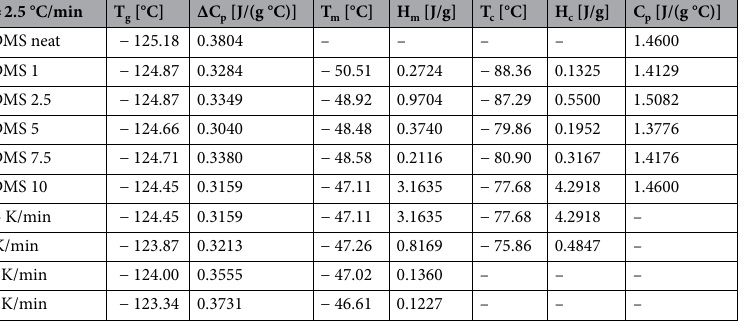
Table 3. Summary of typical values coming from DSC measurement of graphene/PDMS nanocomposites of 1–10 wt% graphene concentration. The heating rate remained constant: 2.5 °C/min. C p was measured in quasi-isothermal mode. The second part of the table shows a summary of typical values coming from DSC measurement for samples with constant 10%wt graphene concentration. The heating rate changed from 2.5